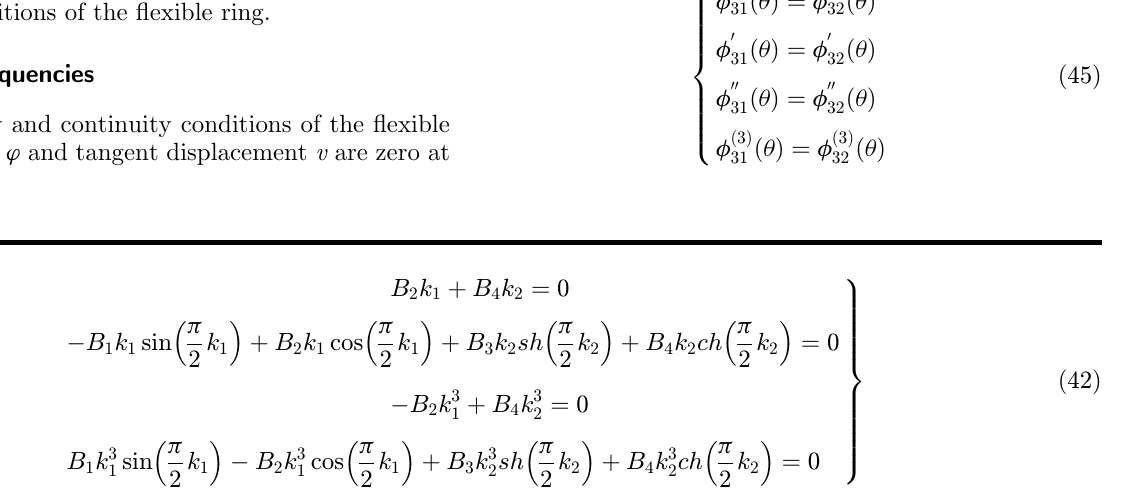
ffiffiffiffiffiffiffiffiffiffiffiffi p (cid:1) 1 þ 1 (cid:1) S